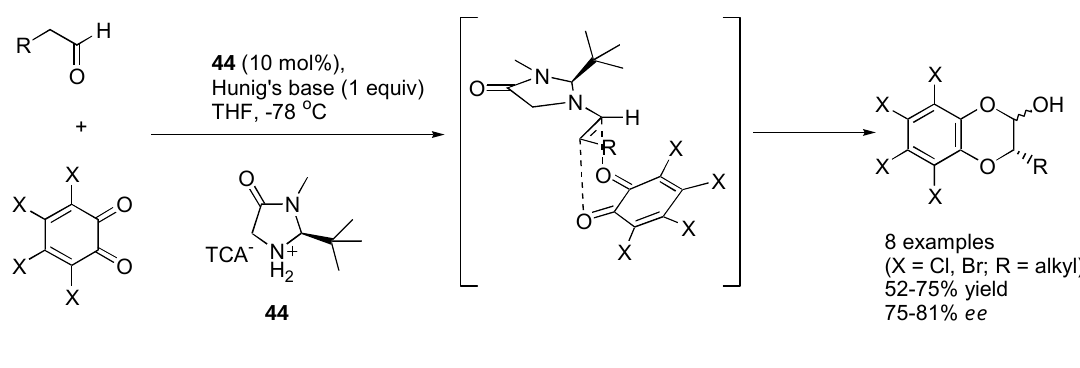
Figure 35. Organocatalyzed  -aryloxylation of aldehydes by o -quinones